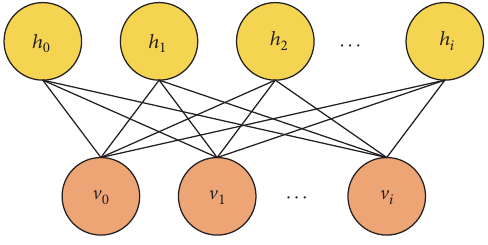
Figure 1: Restricted Boltzmann